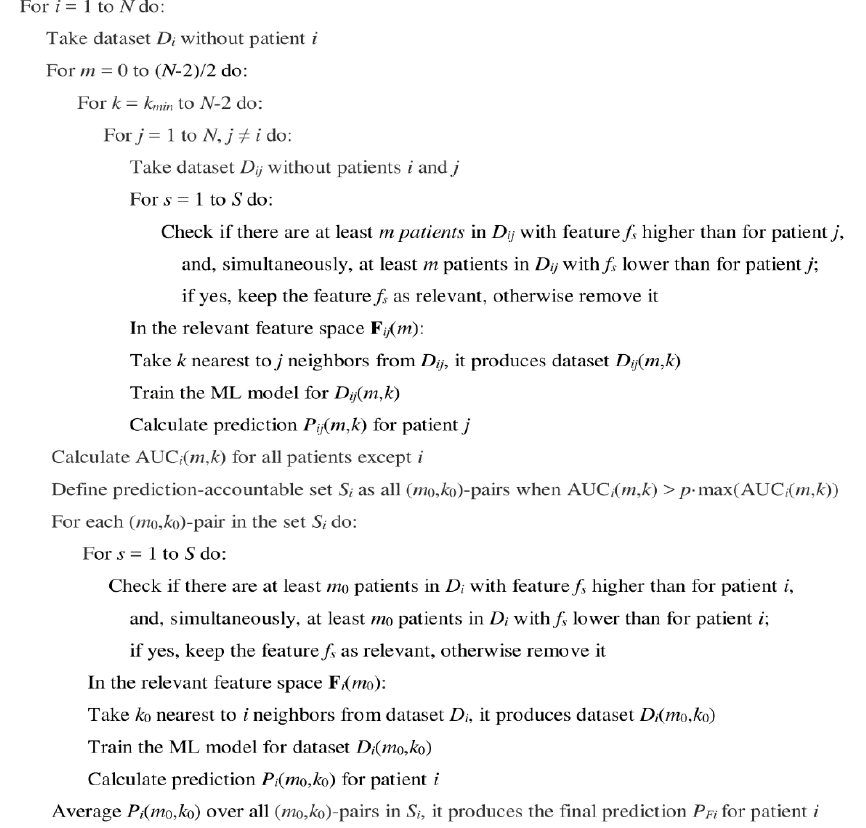
Figure 4. The algorithm of data trimming used for binomial naïve Bayes (LOO) cross-validation of the clinically annotated gene expression datasets. Indexes i and j denote samples (patients), index s denotes pairs of ( m 0 , k 0 )-values in the prediction-accountable set, and indexes m and k denote the data trimming parameters.